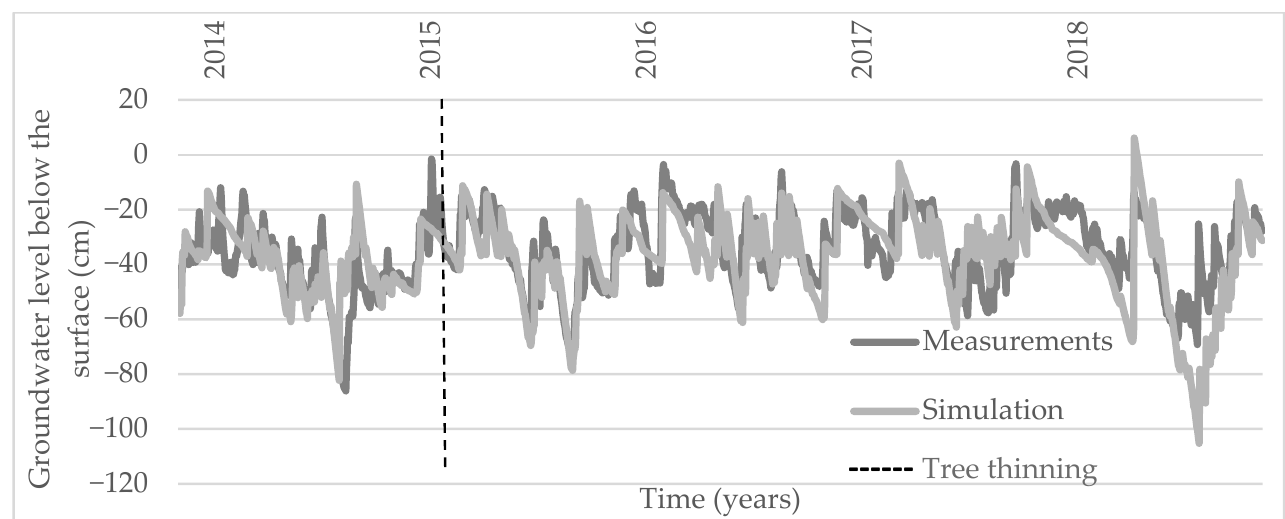
Figure 6. Measured vs. simulated groundwater level in plot 3.